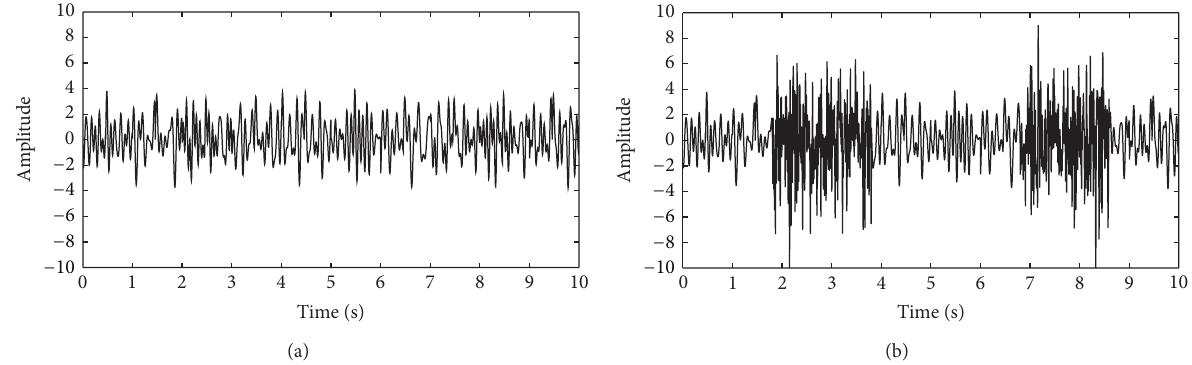
Figure 1: (a) The original EEG data. (b) The contaminated EEG data by muscle